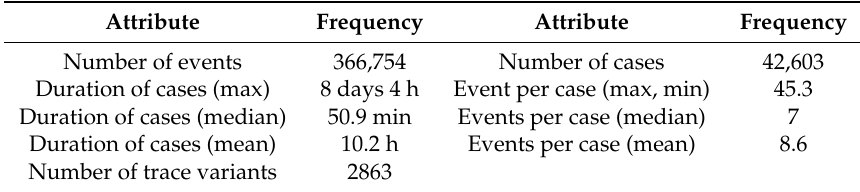
Table 1. Summary of event